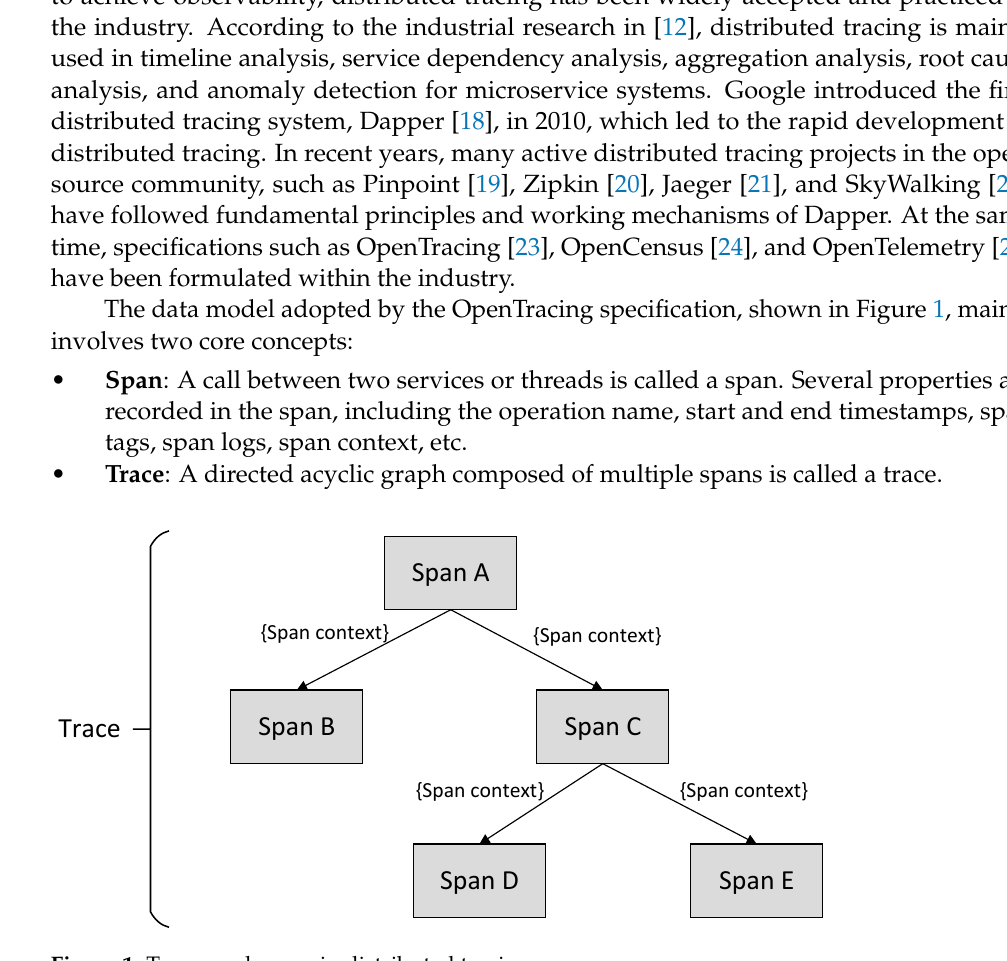
Figure 1. Traces and spans in distributed